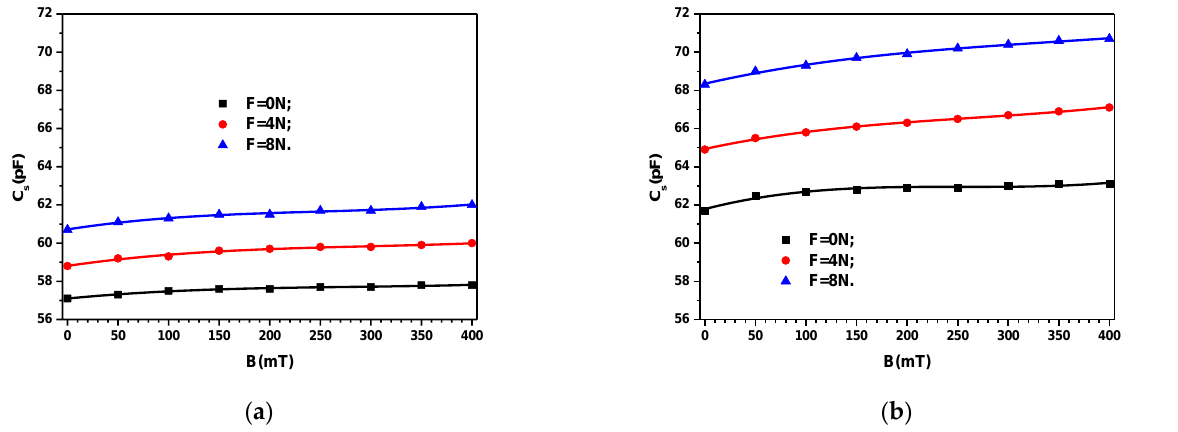
Figure 6. Electrical capacitance Cs of the devices ED as a function of values B of the magnetic flux density superimposed on the electric field with the frequency f = 1 kHz, and values F of the force as a parameter. ( a ) MC 1 . ( b ) MC 2 .